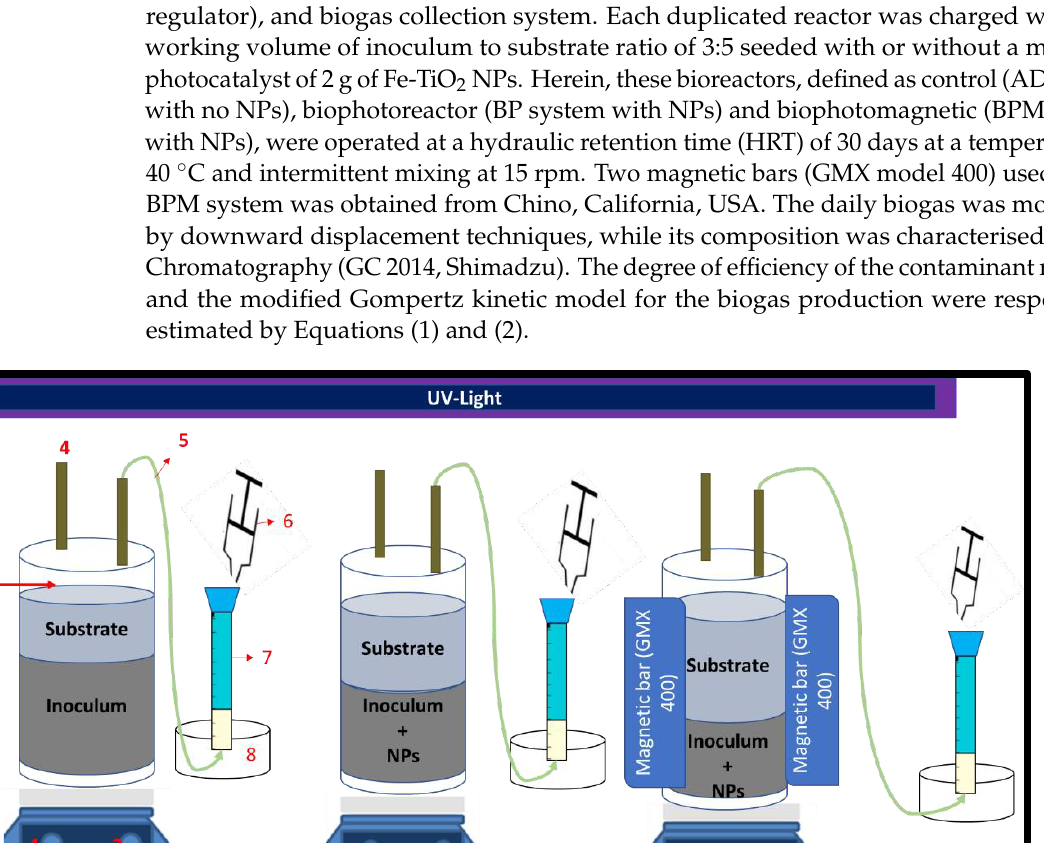
where, 𝐶 𝑖 = Substrate influent and 𝐶 𝑓 = Substrate effluent. The cumulative biogas pro- duction data obtained were evaluated by the modified Gompertz Equation (2) [5,7].